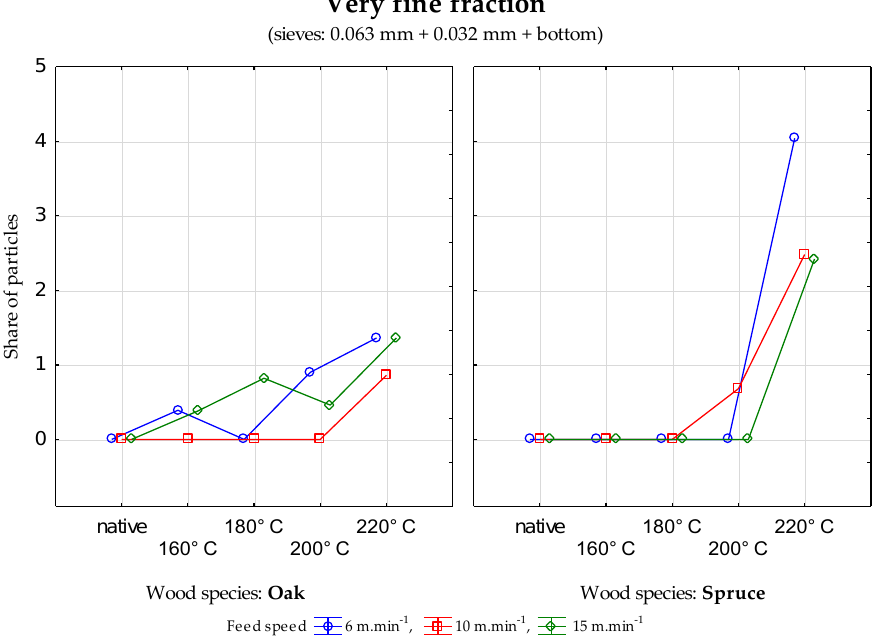
Figure 4. Percentage of very fine particles in the mesh size 0.063 mm, 0.032 mm and the bottom—fine fraction depending upon the modification temperature of oak and spruce.